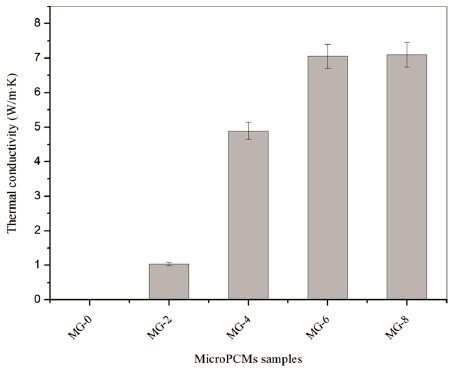
Figure 12. Thermal conductivity values of microPCMs samples.